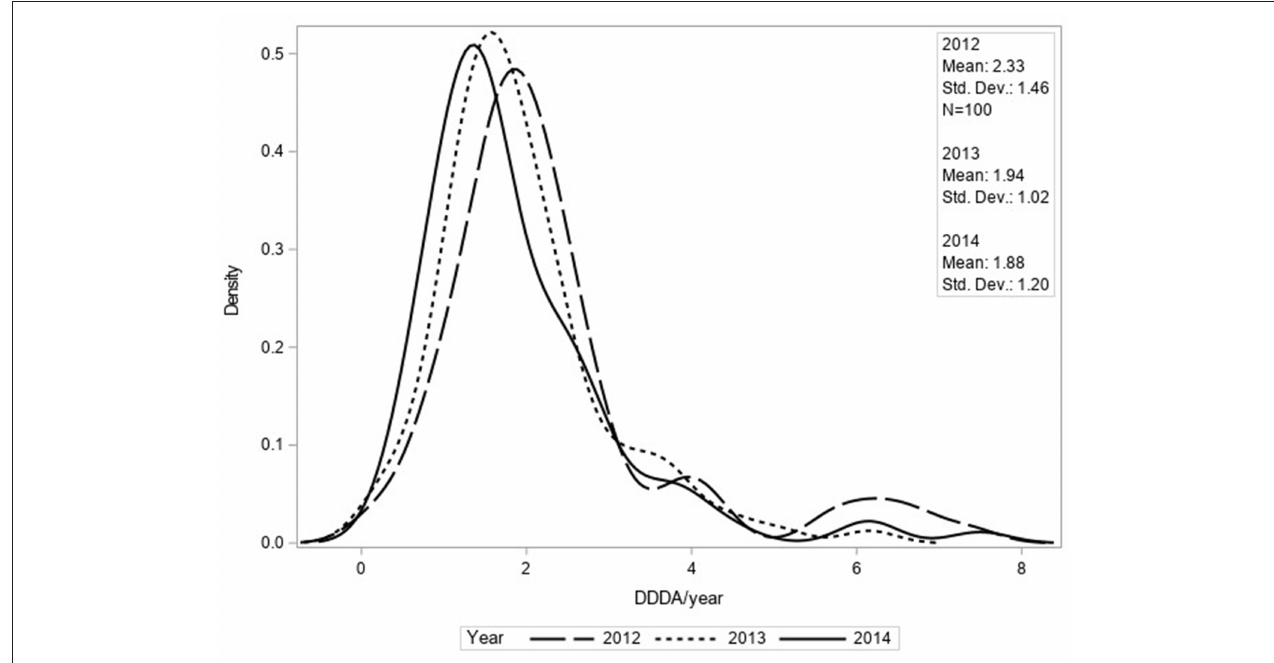
FIGURE 1 | Density function of DDDA CLINIC /year for total AMU based upon procurement data of 100 clinics for 2012, 2013, and 2014.